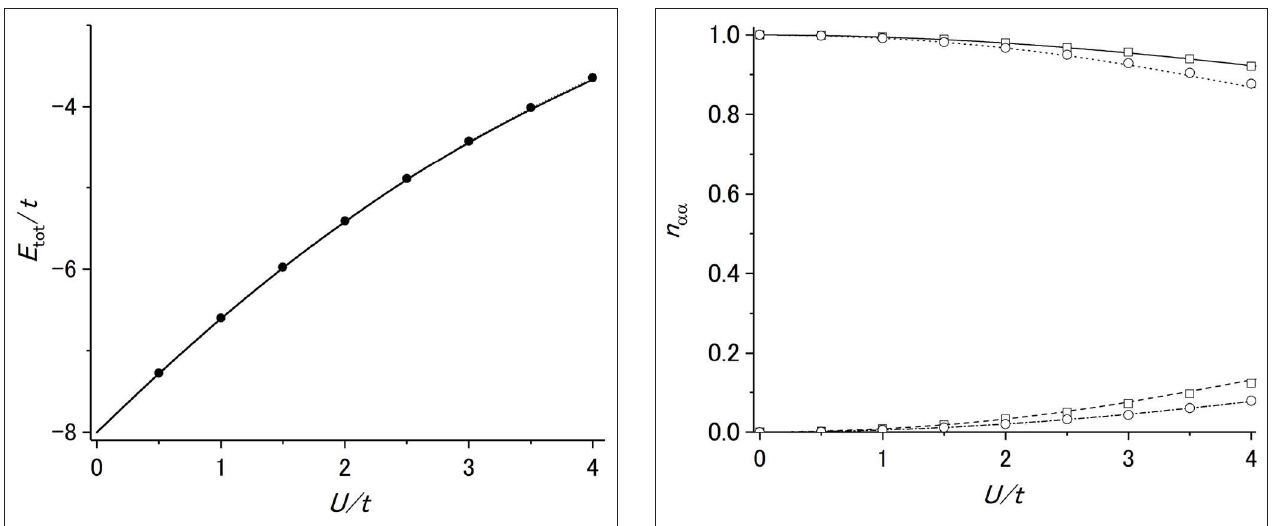
a k a + a k . k 4 k 4 2 ↑ − 2 ↓ ↑ ↓